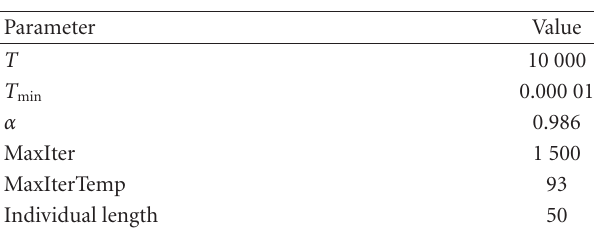
Table 3: Setting of SA.